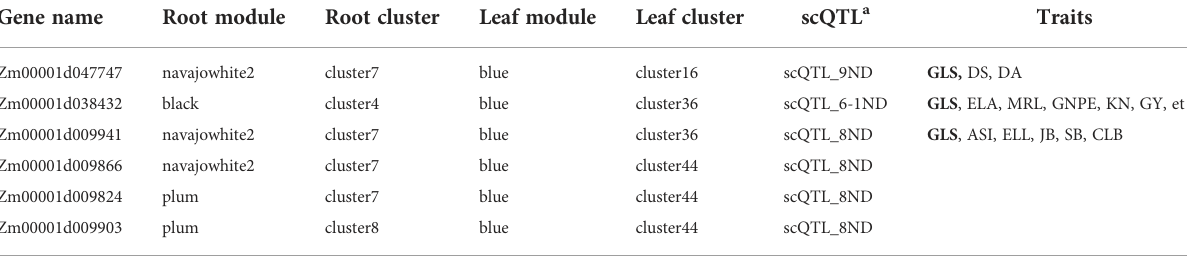
TABLE 2 Six genes were simultaneously screened in root and leaf clusters and